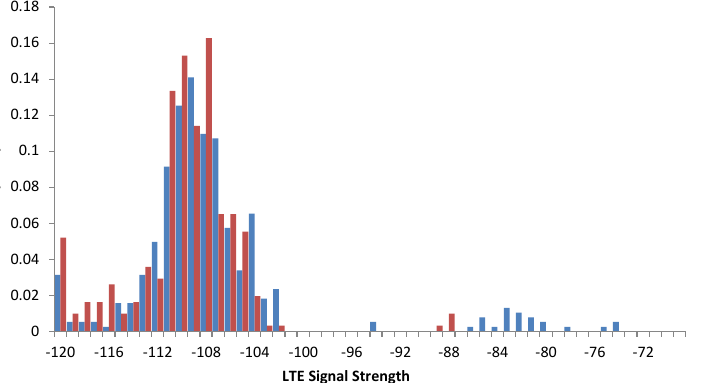
Figure 15. Signal strengths for movements on a single floor (blue) vs . many floors (red).